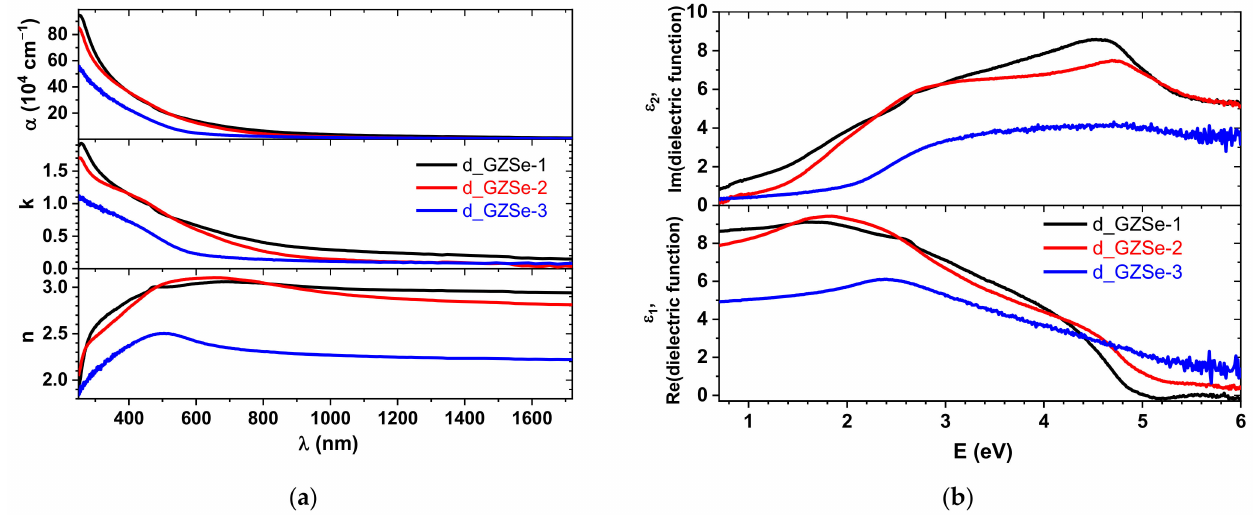
Figure 6. The optical properties of the chalcogenide bulk sintered samples on the mirror-polished surface: ( a ) the refractive index (n), extinction coefficient (k) and the absorption coefficient ( α = 4 π k/ λ ); ( b ) the dielectric function estimated6 from spectroscopic